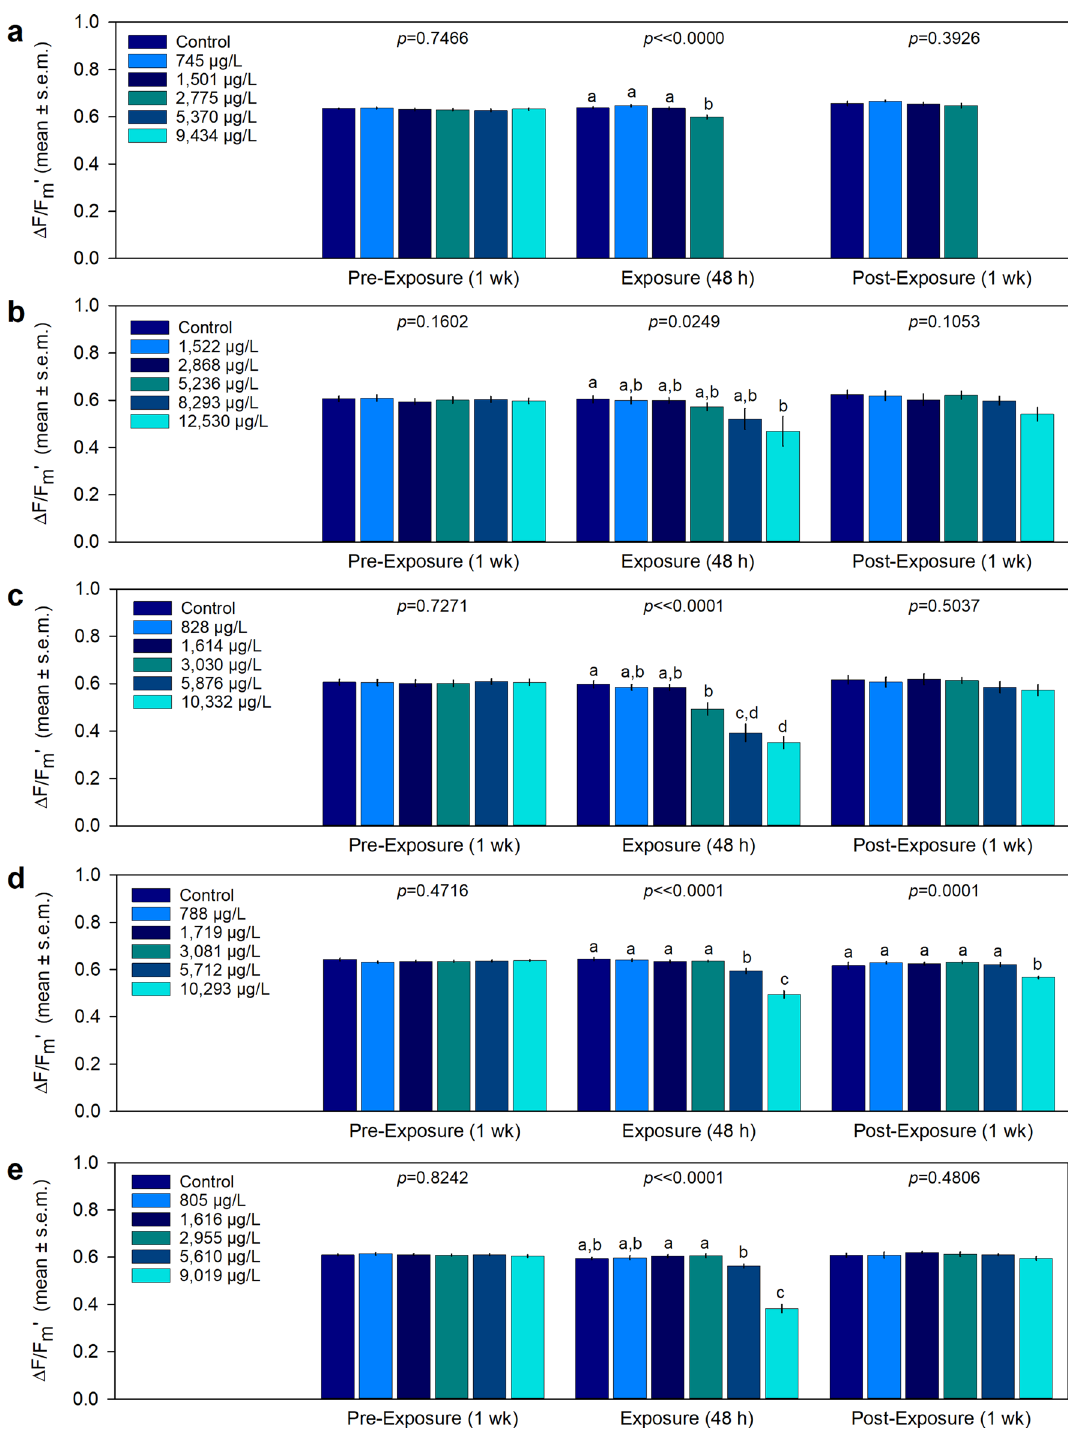
Figure 3. Light-adapted effective quantum yield (mean ± s.e.m.) (n = 4 replicates) during the pre-exposure, exposure, and post exposure periods. ( a ) Acropora cervicornis , ( b ) Porites astreoides , ( c ) Siderastrea siderea, ( d ) Solenastrea bournoni , and ( e ) Stephanocoenia intersepta . Letters above each bar represent statistical differences between treatments at each time point ( a – c ; α =